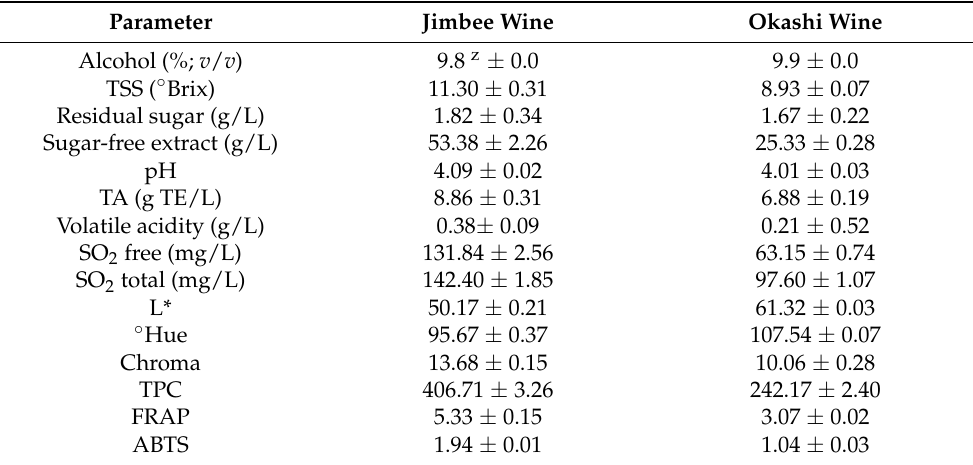
Table 3. Physicochemical parameters of the Jimbee and Okashi melon wines. Parameter Jimbee Wine Okashi Wine Alcohol (%; v / v )